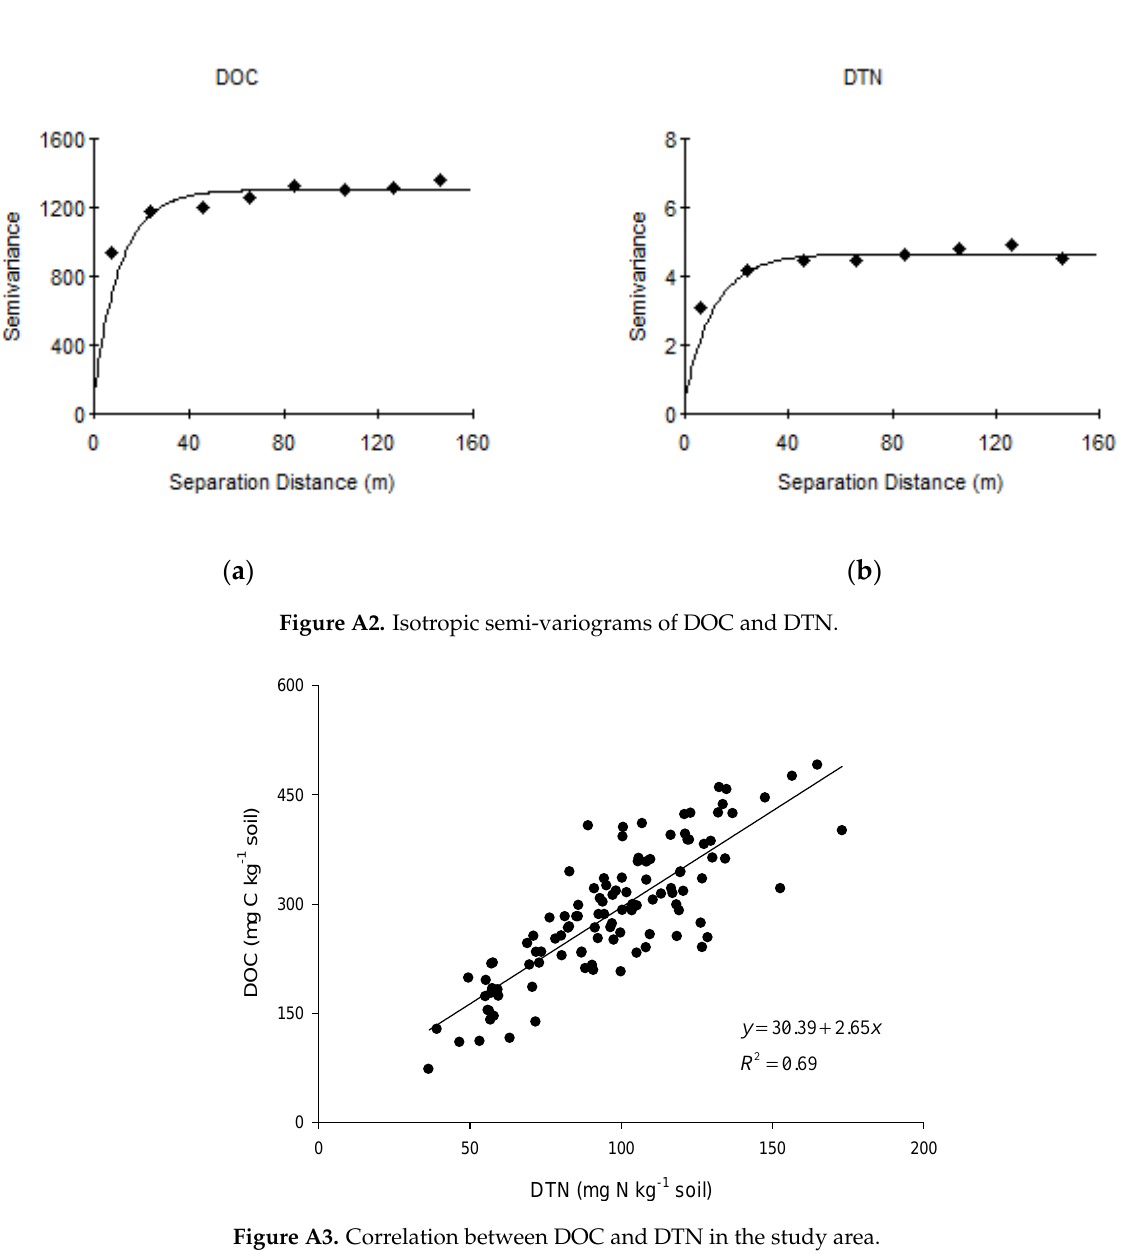
Figure A3. Correlation between DOC and DTN in the study area.